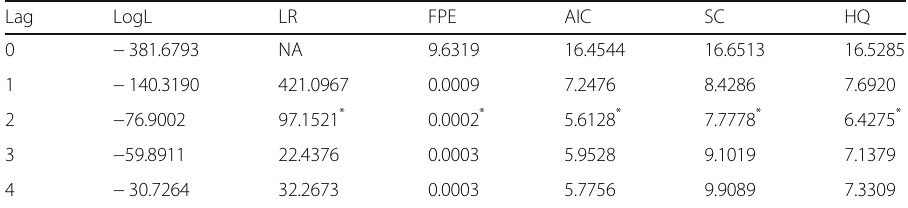
Table 2 Lag length criteria for